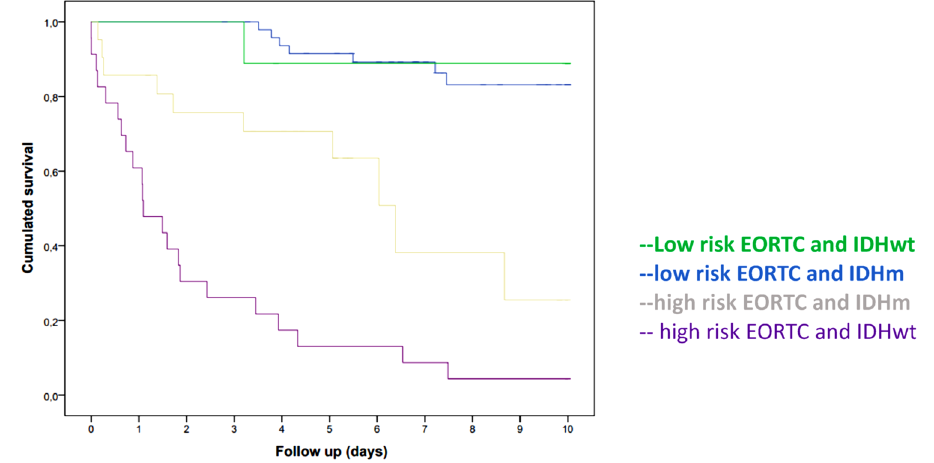
Figure 1. Overall survival analysis as a function of EORTC score and HDI